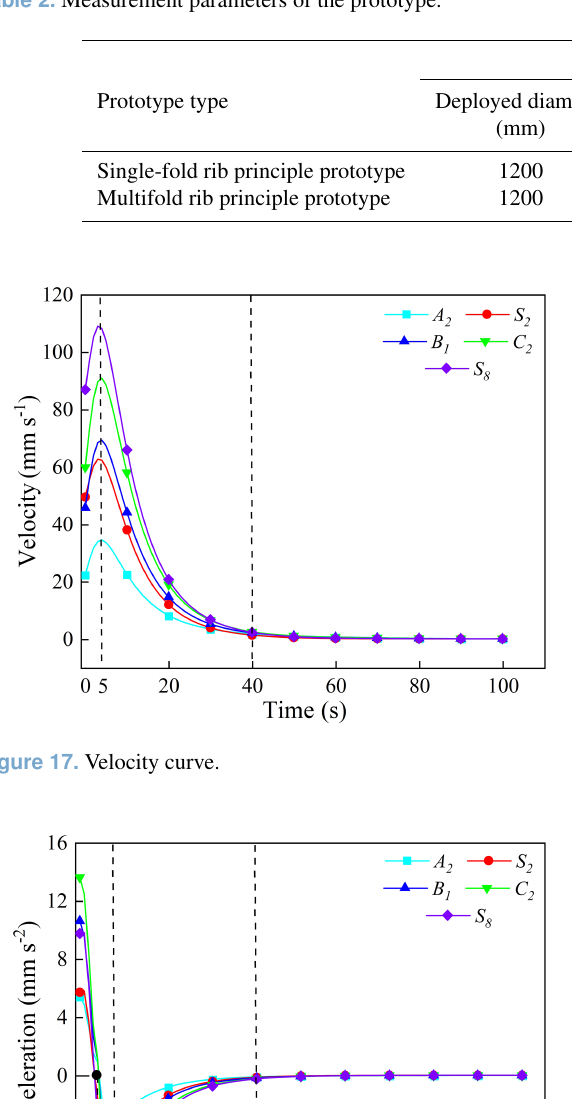
Table 2. Measurement parameters of the prototype.